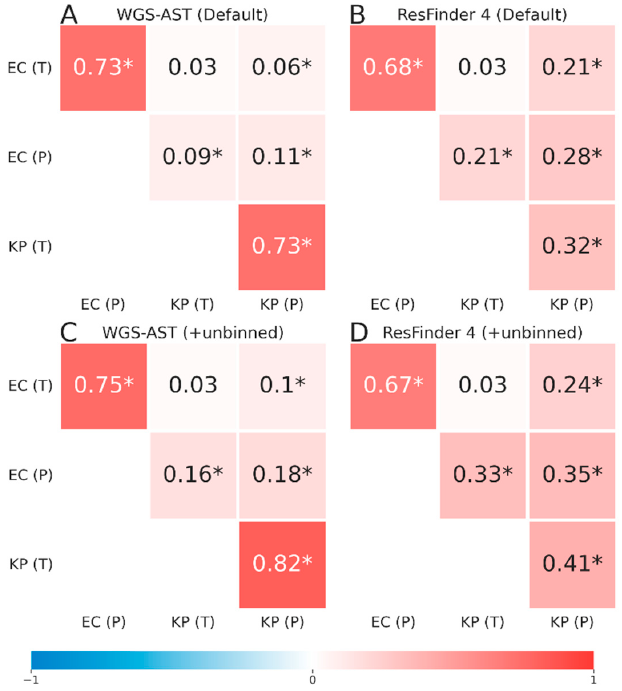
Figure 4. Pearson correlation of True and Predicted AST status of metagenomic bins in E. coli / K. pneumoniae co-infection metagenomes. ( A , B ), correlation for WGS-AST and ResFinder 4 classifiers, respectively, on metagenomes binned with default settings. ( C , D ), correlation for WGS-AST and ResFinder 4 classifiers, respectively, on metagenomic bins with added DAS Tool unbinned contigs. EC, Escherichia coli . KP, Klebsiella pneumoniae . (T), true AST status. (P), predicted AST status. Correlations with significance at p < 0.05 indicated with